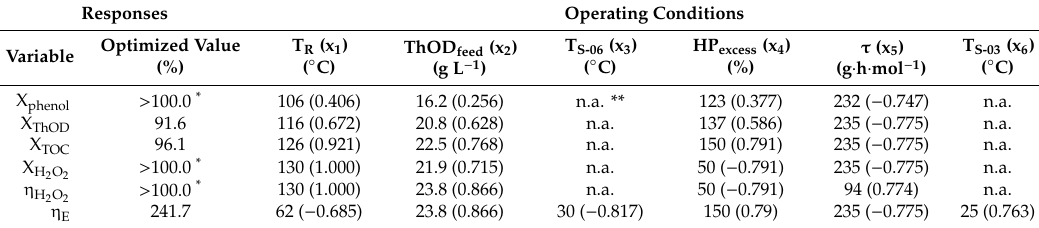
Table 4. Optimal operating conditions for each individual